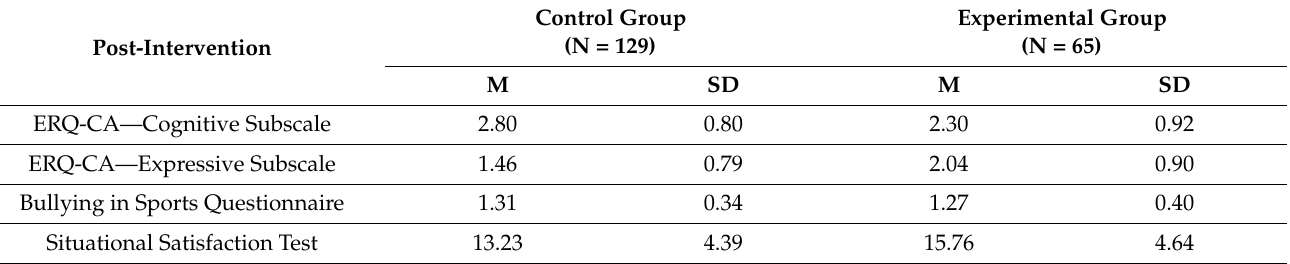
Table 4. Post-intervention descriptive data for participants in the experimental and control group.